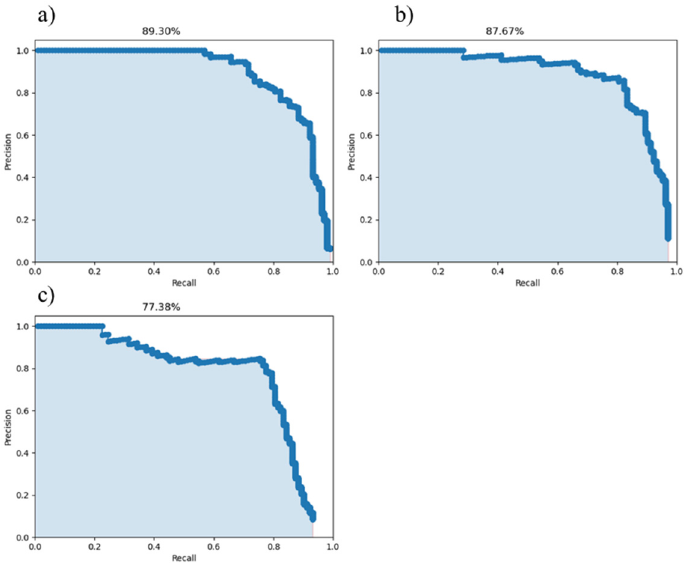
Figure 16. AP comparison of three networks: ( a ) AP of DToolnet; ( b ) AP of resnet50 ‐ based Faster RCNN; ( c ) AP of vgg16 ‐ based Faster RCNN.